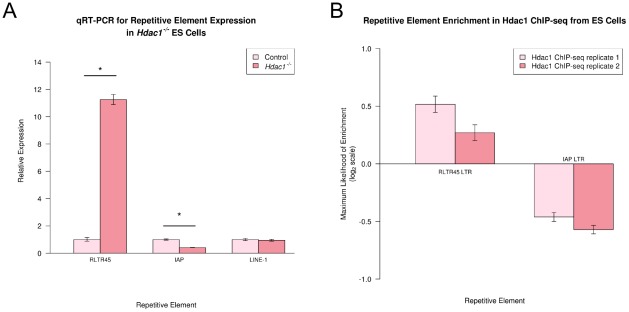
Hdac1 regulates expression of LTR retrotransposons in mouse ES cells.(A) qRT-PCR verification of LINE-1, RLTR45 and IAP expression in Hdac1−/− ES cells. Expression levels (mean ± standard error for three biological replicates) were normalized to β-Actin and expressed relative to control ES cells. IAP and LINE1 5′UTR primer sets (Figure S2) were used to assess IAP and LINE-1 expression. Asterisks indicate a statistically significant difference (p<0.05) for RLTR45 and IAP elements. RLTR45 expression is upregulated in Hdac1−/− ES cells, but IAP expression is downregulated. (B) Enrichment of LTR retrotransposon sequences in Hdac1 ChIP-seq data from mouse ES cells. The maximum likelihood of enrichment (±95% confidence intervals) for RLTR45 LTR and IAP LTR sequences Hdac1 ChIP-seq relative to whole cell extract is shown. RLTR45 LTR sequences are enriched in the Hdac1 ChIP-seq indicating a physical association between Hdac1 and RLTR45 retrotransposon chromatin, in contrast IAP LTR sequences are depleted.